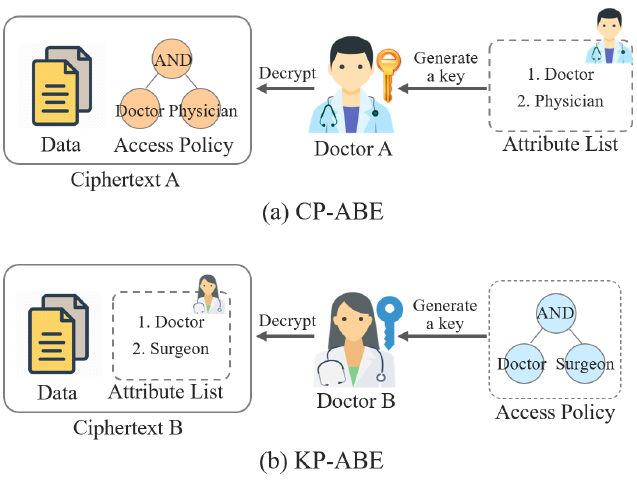
Figure 6. Overview of ABE